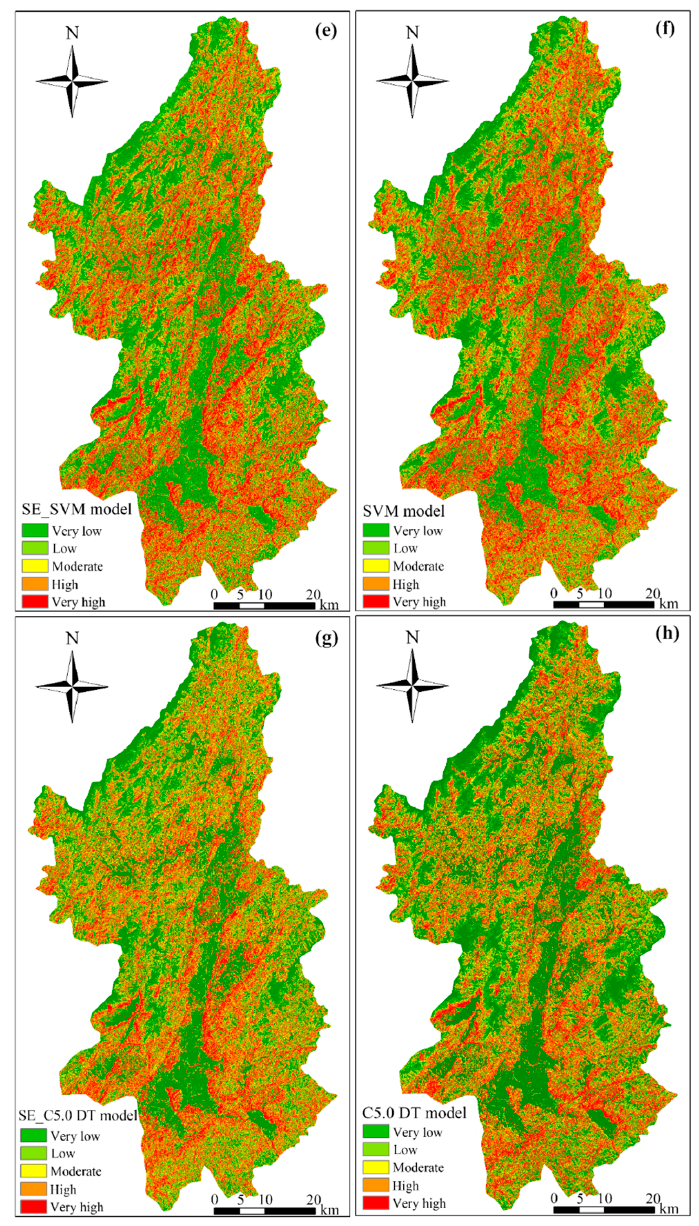
Figure 5. Landslide susceptibility maps with 30 m grid resolutions: ( a ) SE_MLP model; ( b ) MLP model; ( c ) SE_LR model; ( d ) LR model; ( e ) SE_SVM model; ( f ) SVM model; ( g ) SE_C5.0 DT model; ( h ) C5.0 DT model.